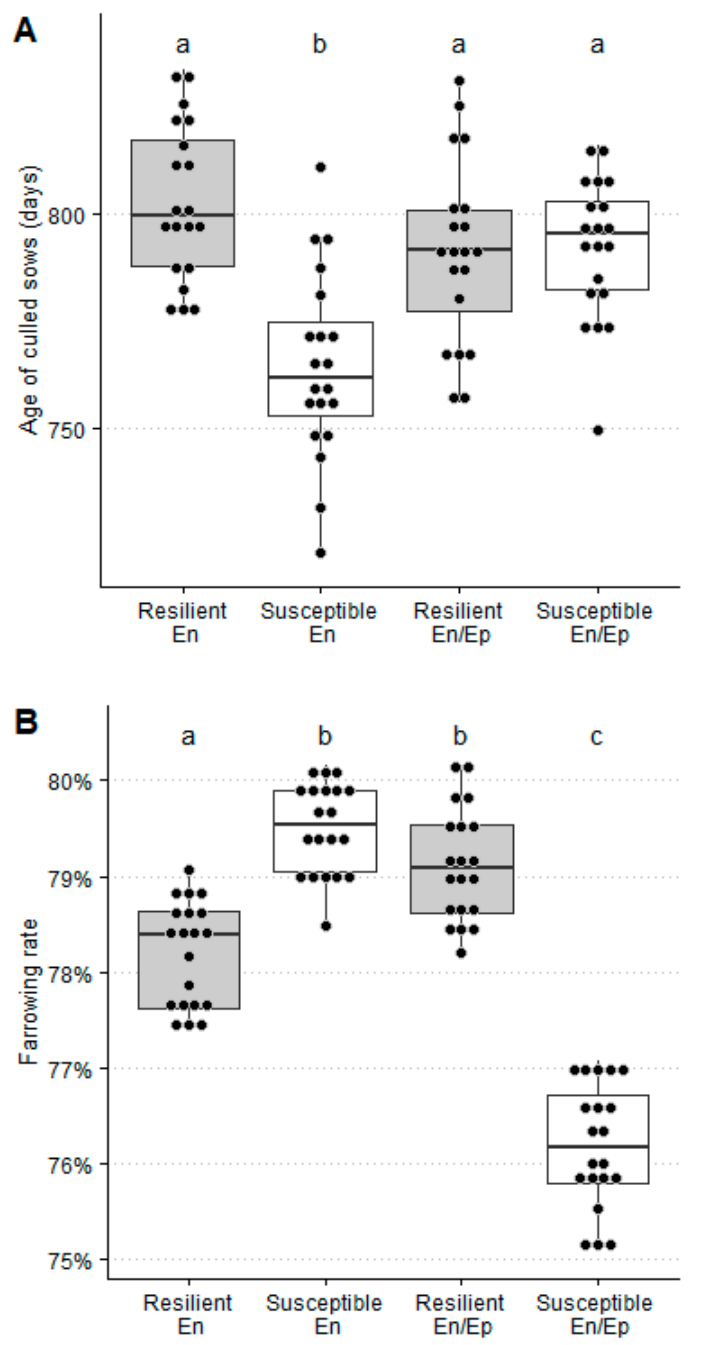
Figure 3. Number of piglets produced by sow and year ( A ), and the number of piglets produced by culled sow ( B ) for porcine reproductive and respiratory syndrome (PRRSV) resilient and sus- ceptible sows in a PRRSV endemic-infected farm not suffering (En) or experiencing (En/Ep) one epidemic PRRSV outbreak with an average duration of 24 weeks within three years. Bars with different superscripts showed statistically significant differences ( p < 0.05).